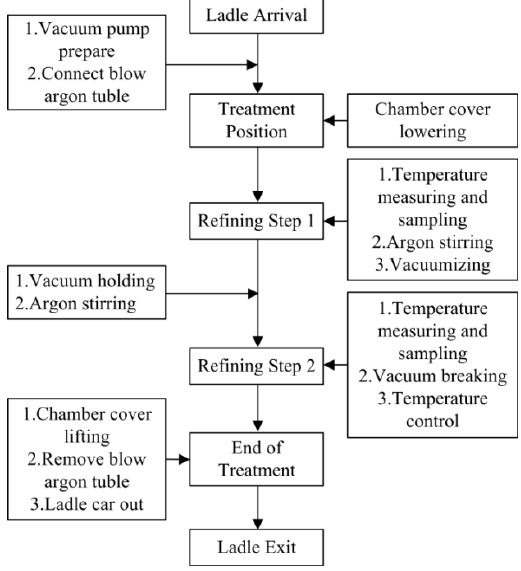
Figure 1. Process flow diagram of VTD.